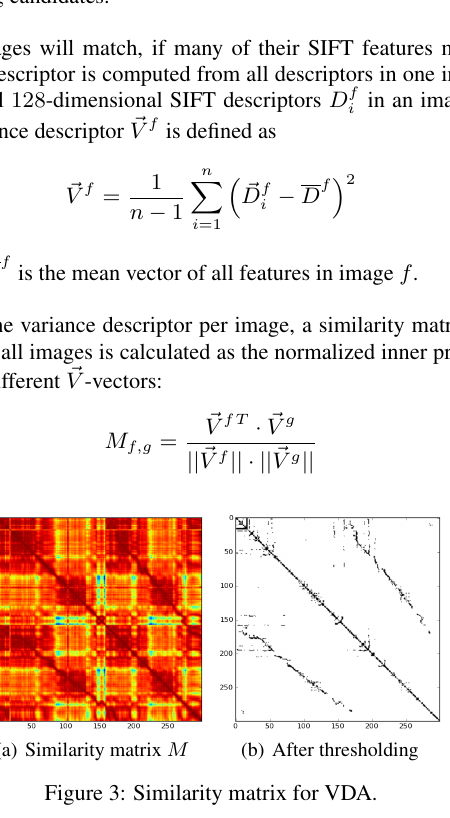
Figure 5: Spanning tree from the most central node to each camera for the Herz-Jesu-P25